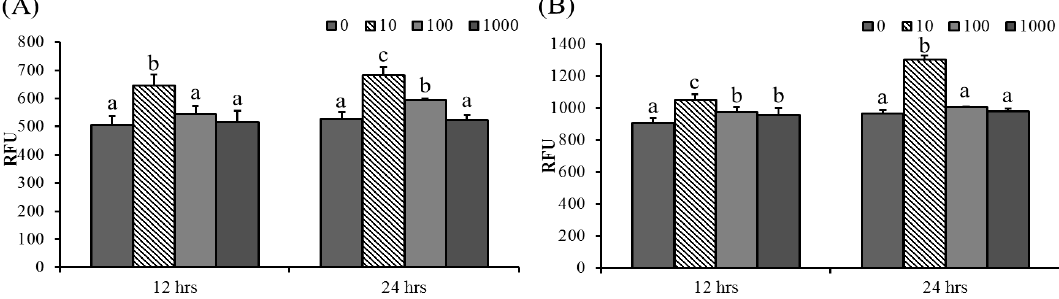
Figure 2. ABSSE induces phagocytic activity in hepatic and splenic macrophages. Hepatic ( A ) and splenic ( B ) macrophages were treated with 0, 10, 100, or 1000 μg/mL of Agaricus blazei spent substrate extract (ABSSE) in RPMI 1640 medium for 12 and 24 h prior to addition of a bioparticle solution. The relative fluorescence units (RFU) were measured and are shown as means + SEM. Significant differences between experimental groups ( p < 0.05, one-way ANOVA, and Tukey’s post hoc test) are indicated by different letters.